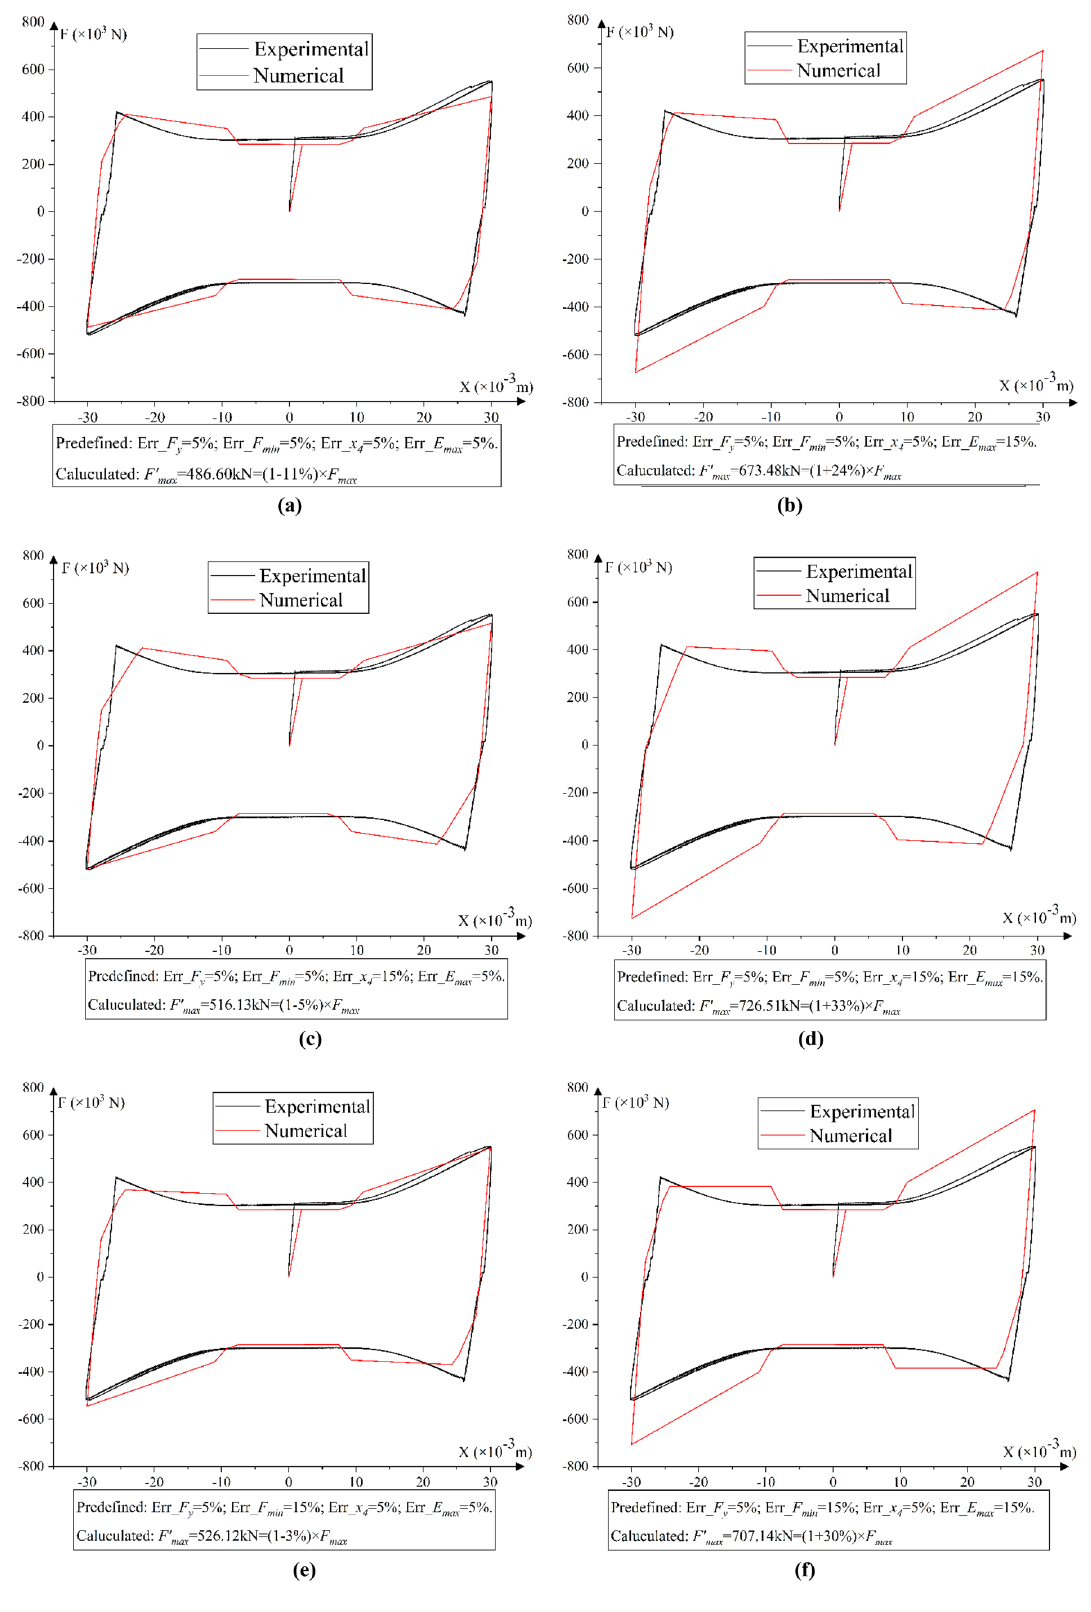
Fig. 20 Yielded 16 hysteresis respectively corresponding to 16 sets of equivalent modelling parameters optimized regarding 16 distinct sets of error ratios